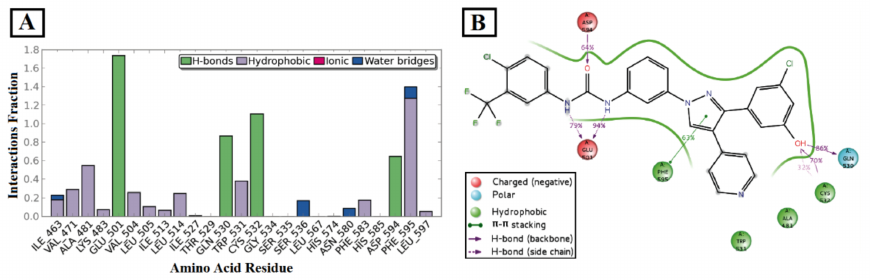
Figure 75. V600E-B-RAF-compound 71 binding interactions throughout the 50 ns simulation period; ( A ) the fractions of interaction happened between compound 71 and V600E-B-RAF kinase. ( B ) 2D interaction diagram of compound 71 within V600E-B-RAF active site